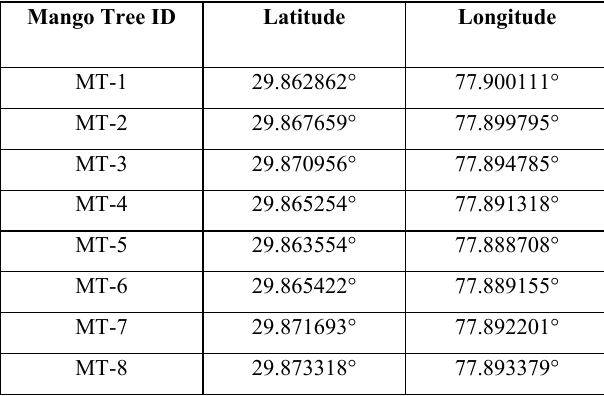
Figure 3(b) shows the spectral-response visualization over SVC PC Data Acquisition software for MT-4 mango